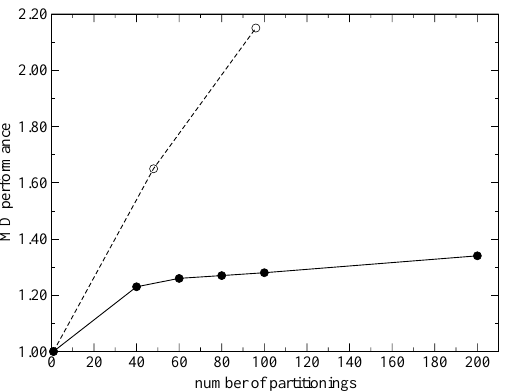
Figure 1. MD performances (wall-time per one MD step) of the SCMP simulations relative to a conventional QM/MM simulation that has the same size of the QM region. Filled circles and the solid line represent the results in the present study and open circles and the dashed line represent the results in a previous study [14]. The benchmark simulations were conducted for a system composed by 2048 water molecules, where the QM region consisted of one solute water and 32 solvent water molecules.